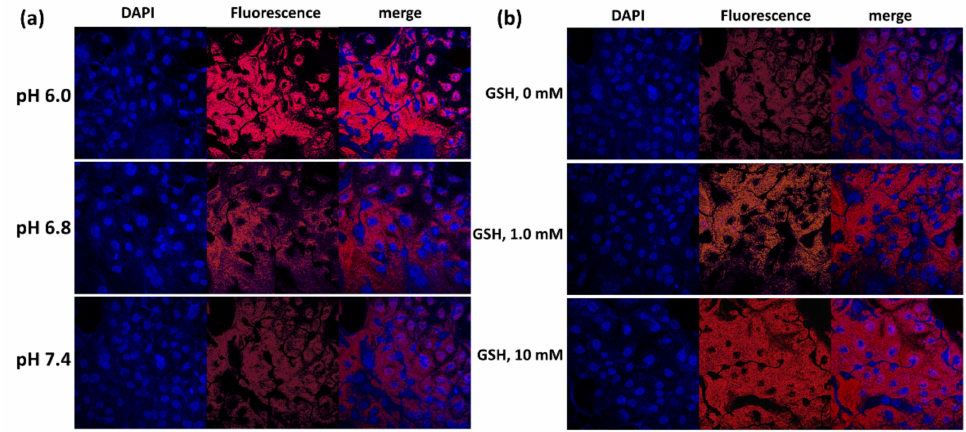
Figure 9. Morphological observation of DOX-resistant HuCC-T1 cells using a confocal microscope. The effect of media pH ( a ) and the addition of GSH ( b ) on the uptake of ChitoHISss nanoparticles in DOX-resistant HuCC-T1 cells. Cells were exposed to Ce6-incorporated ChitoHISss nanoparticles for 90